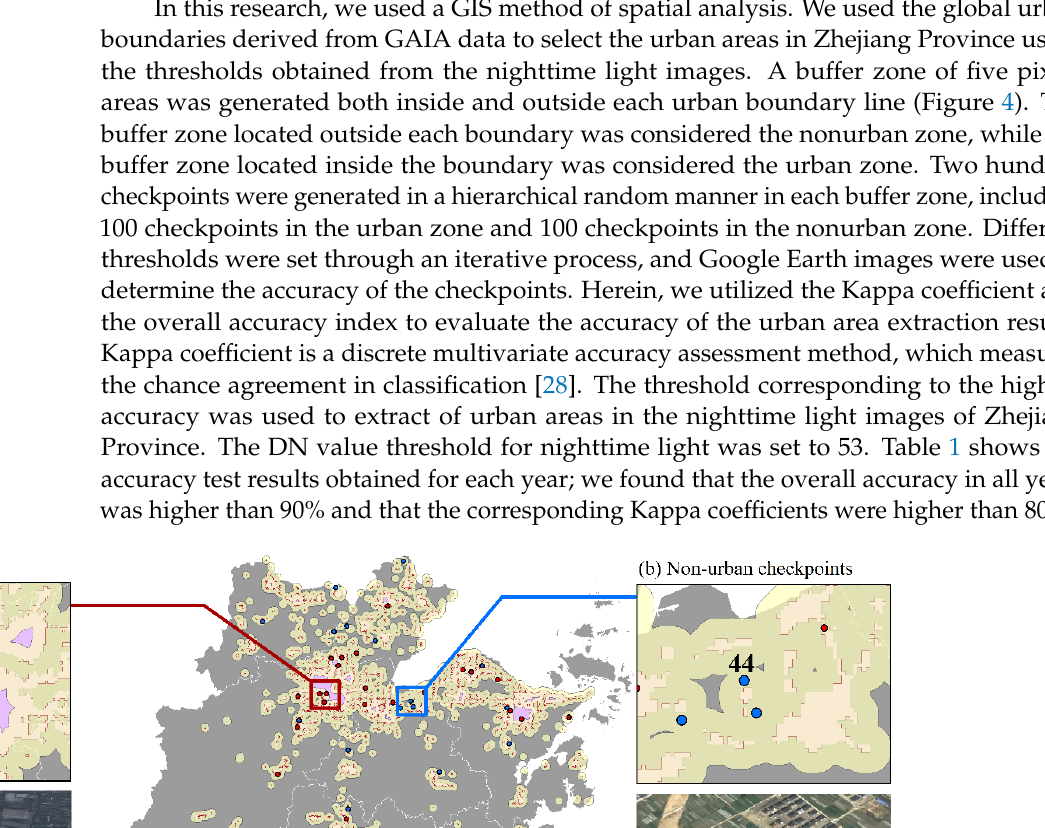
Figure 3. Results of the NPP/VIIRS nighttime light image normalization in Zhejiang Province from